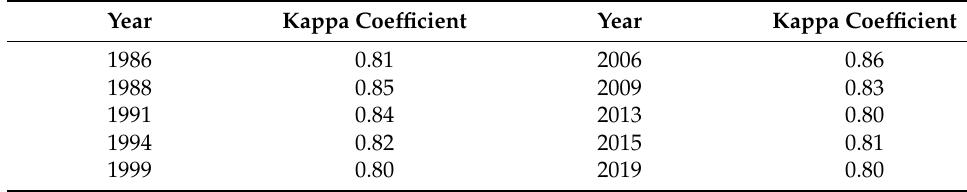
Figure 14. Fish ponds in Google Earth high resolution image ( A ) and Landsat image ( B ).